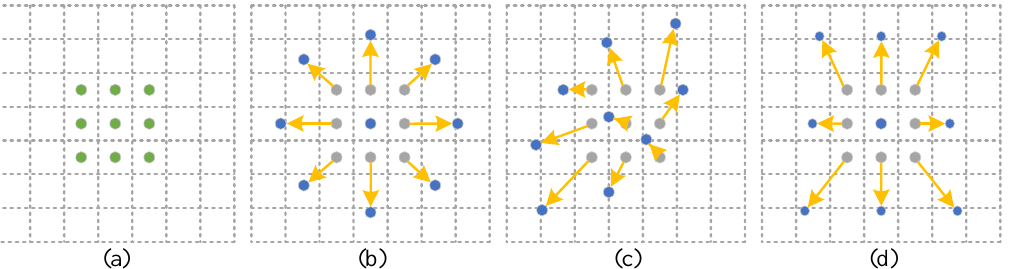
Figure 2. Illustration of the sampling locations in 3 × 3 standard and deformable convolutions. ( a ) Regular sampling grid of standard convolution; ( b – d ) deformed sampling locations of deformable convolution with augmented offsets. The green areas are the sampling locations in 3 × 3 standard convolution. The gray areas and the blue areas are the initial sampling locations and final sampling locations of the deformable convolution, respectively. The yellow arrow points from the initial sampling location to the corresponding final sampling location.